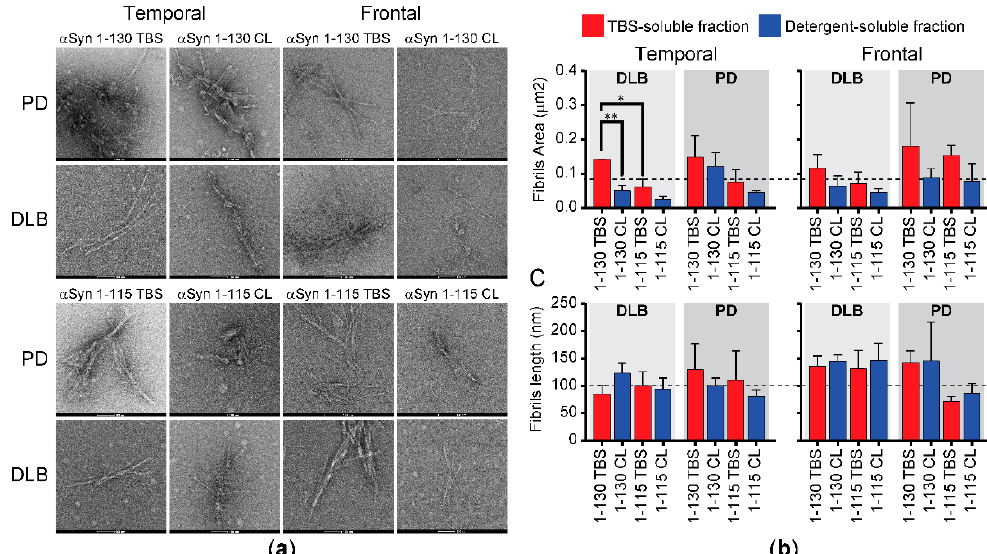
Figure 6. Morphological characterization of C ‐ terminally truncated RT ‐ QuIC end products by TEM. ( a ) Representative TEM images of RT ‐ QuIC end products with the samples derived from PD and DLB temporal and frontal cortices. ( b ) Area of aggregated fibrils and ( c ) length of fibrils in each aggregate structure were calculated from the TEM images of the RT ‐ QuIC end products using ImageJ; 5 to 10 fibrils per aggregate structure were measured to calculate the average fibril length per aggregate. Bar graphs show the average +SEM (n = 3 biological replicates (cases) per condition, except for PD TBS Frontal 1 ‐ 115 where n = 2 cases). One ‐ way ANOVA with Tukey’s multiple comparison testing (GraphPad Prism) was used for statistical comparisons; * p < 0.05, ** p < 0.01. The dotted lines in panels B and C show the average fibril area and fibril length from the temporal cortex samples, respectively.